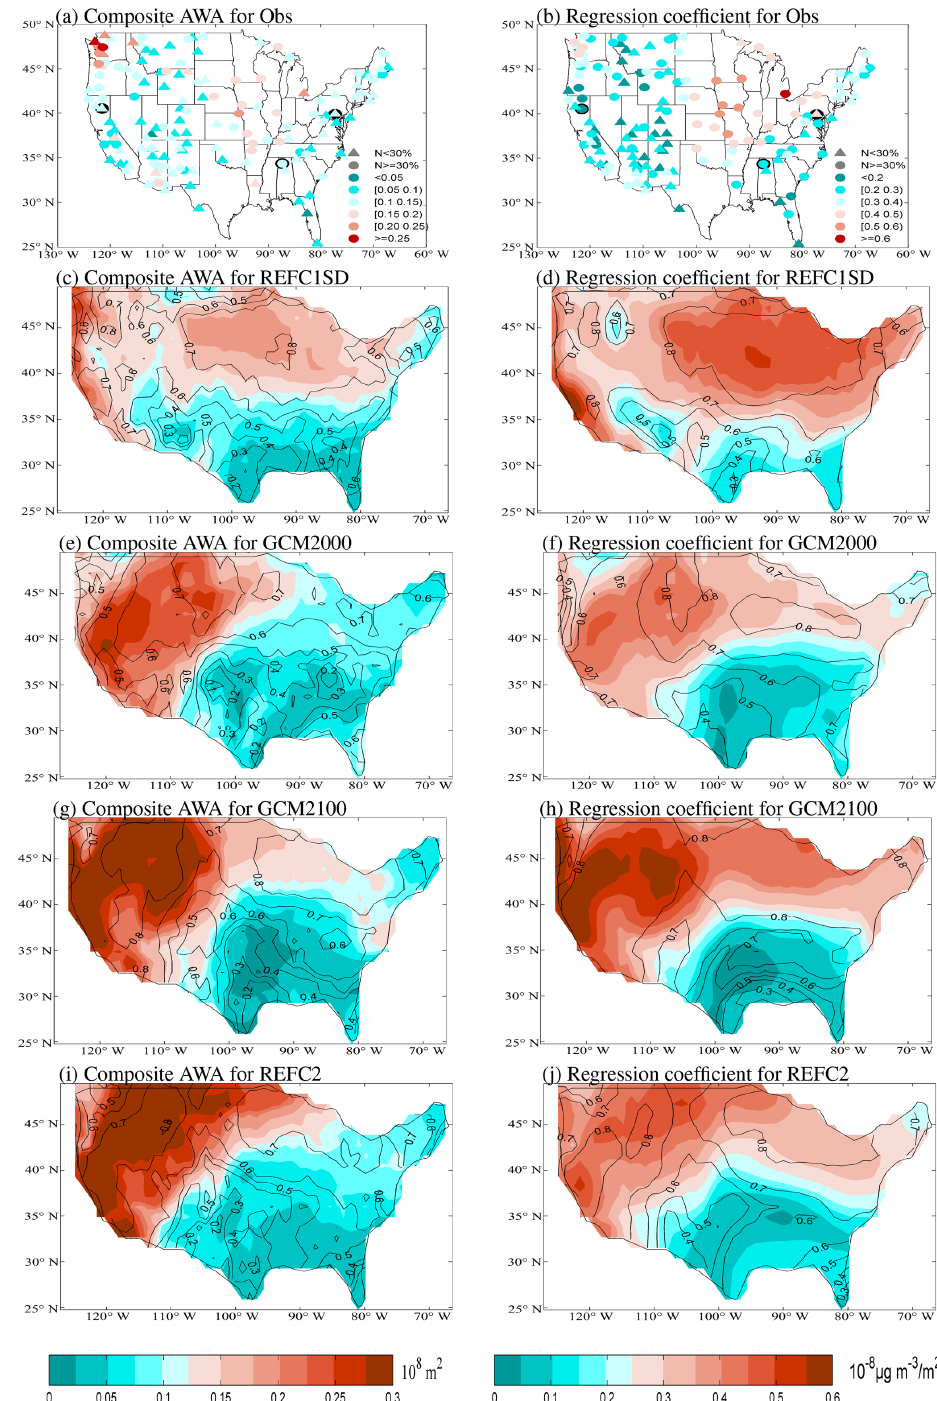
Figure 6. The maximum of the composite AWA distribution for PM 2 . 5 larger than the 90th quantile (shaded) (a, c, e, g, i) and the centers of the spatial regression coefficient distribution between PM 2 . 5 and AWA (b, d, f, h, j) : observations (Obs, first row), current climate from the reanalysis-driven simulation (REFC1SD, second row), current climate from the coupled model simulation (GCM2000, third row), future climate with current emission (GCM2100, fourth row) and future climate with future emission (REFC2, bottom row). At each grid point, the highest composite AWAs anywhere in the domain based on the PM 2 . 5 larger than the 90th quantile and the highest regression coefficient between AWA and PM 2 . 5 are shown. In (a) and (b) , the thee representative sites are denoted by the black dots. In (a) and (b) the different shapes (circles or triangles) indicate whether the number of values for every grid that are statistically significant (at the 5% confidence level) is more than 30% or not. The different colors indicate different highest composite AWA and regression coefficients as indicated in the legend. In (c) through (j) the number of values for every grid that are statistically significant at the 5% confidence level is shown (in black contours). https://doi.org/10.5194/acp-22-7575-2022 Atmos. Chem. Phys., 22, 7575–7592,